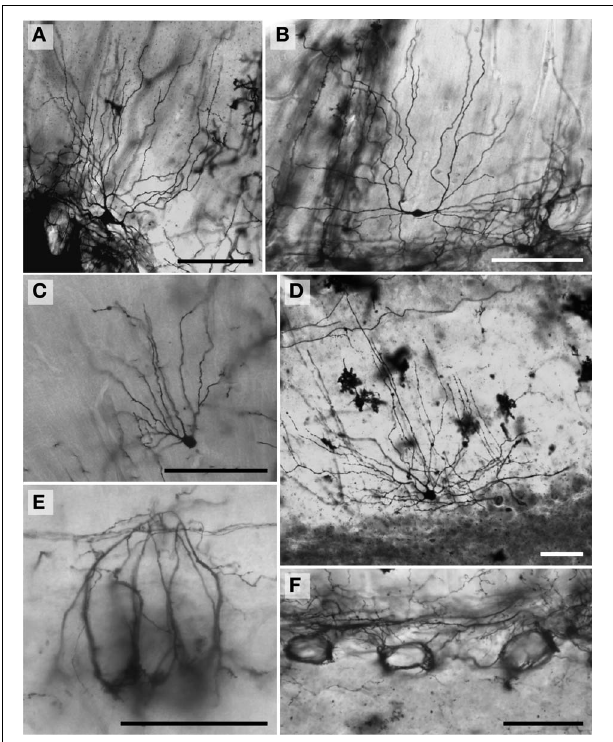
FIGURE 3 | Photomicrographs of Golgi-stained basket neurons. (A) Humpback whale; (B) chimpanzee; (C) giraffe; and (D) African elephant. The pericellular baskets encapsulating Purkinje cell bodies (unstained) are represented in (E) Siberian tiger and (F) humpback whale. Scale bars: 100 μ